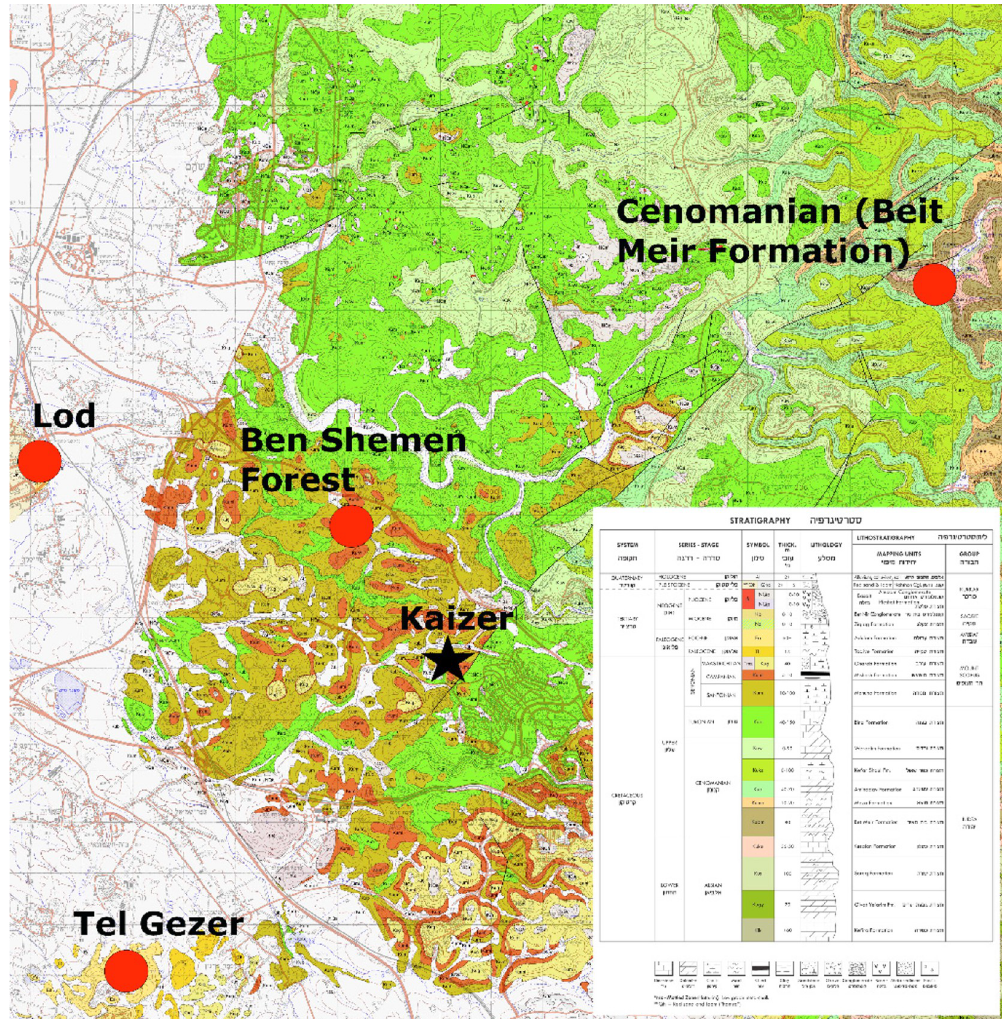
Fig 16. The geologic setting of Kaizer Hill (following [20]). Note the interchanging Campanian and Turonian outcrops in the immediate vicinity of the site. Reprinted from Yechieli 2008, under a CC BY license. It is taken from the Geological survey of Israel website (public domain), with permission from Dr. Amit Mushkin of the Geological survey of Israel, original copyright